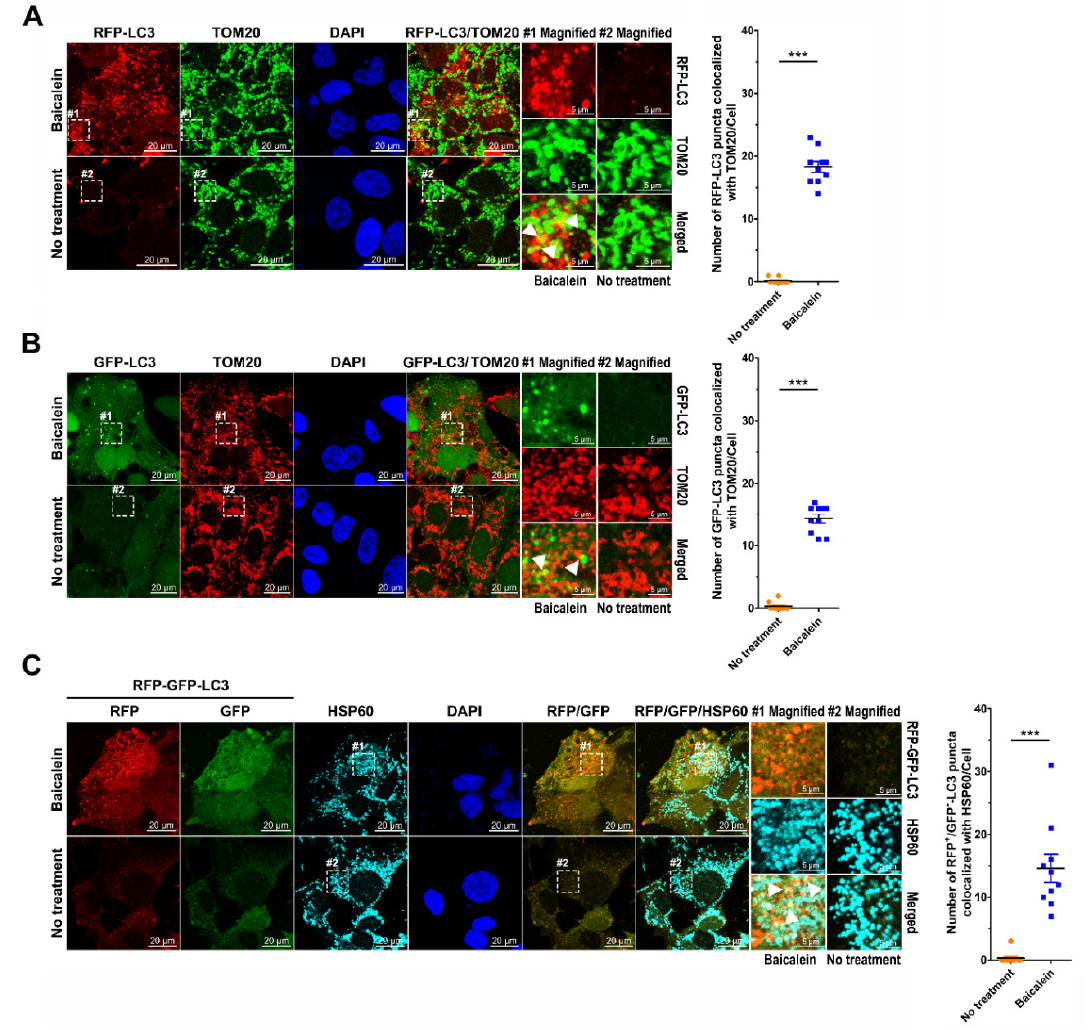
Figure 4. Colocalization of autophagic vacuoles and mitochondria in baicalein-treated cells: ( A ) Huh7/RFP-LC3 cells were treated with or without 0.5 mM baicalein for four hours. Then, the cells were fixed, immunostained for TOM20 (green) and nuclei by DAPI (blue), and analyzed by confocal microscopy. ( B ) Huh7/GFP-LC3 cells were treated with baicalein as described above, immunostained for TOM20 (green) and nuclei (blue), and assessed by confocal microscopy. ( C ) Huh7/RFP-GFP-LC3 cells were cultured in the presence or absence of 0.5 mM baicalein. Four hours later, the cells were fixed and immunostained for HSP60 (cyan) and DAPI (blue) and subjected to confocal microscopy analysis. The number of RFP-LC3 puncta colocalized with TOM20 ( A ), the number of GFP-LC3 puncta colocalized with TOM20 ( B ), and the number of RFP + /GFP − autolysosomes overlapping with the HSP60 signal ( C ) were quantified. The data represent the means ± SEM ( n = 10, *** p < 0.001). In each panel, magnified field-1 and magnified field-2 show enlarged images of the areas in white dashed boxes 1 and 2 in the images of baicalein-treated and untreated cells, respectively. The white arrowheads in magnified field-1 indicate the colocalized